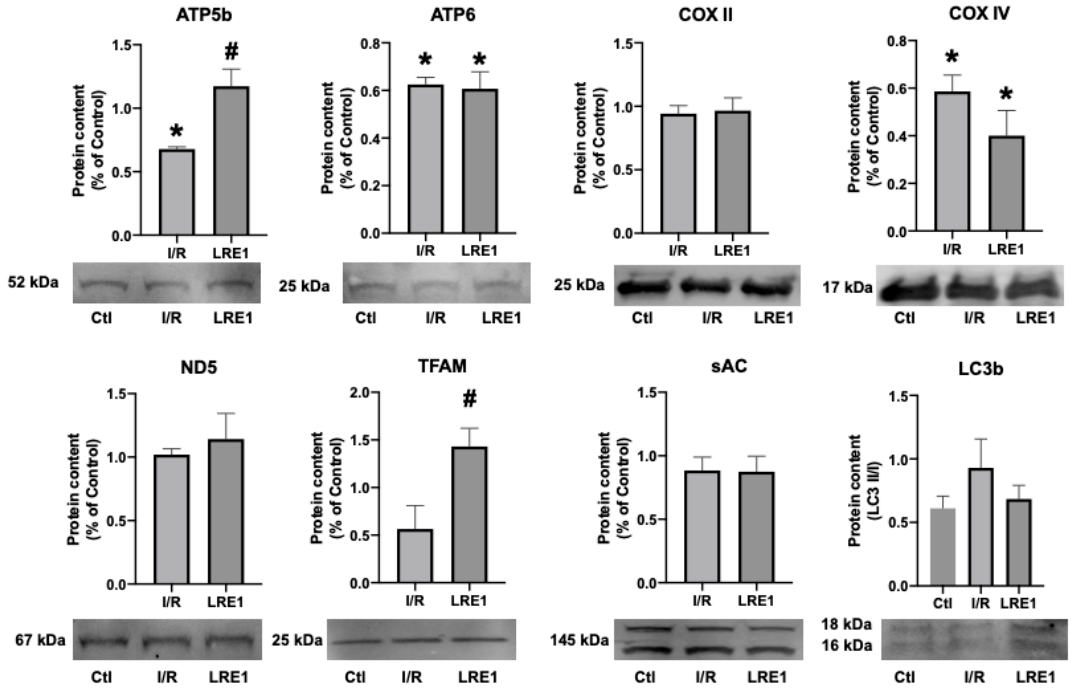
Figure 6. Hepatic mitochondrial protein content quantification by Western blot. Data are means ± SEM of 4 independent experiments. ATP5b, ATP synthase F1 subunit beta, mitochondrial; ATP6, ATP synthase F O subunit 6, mitochondrial; COX II, cytochrome c oxidase subunit II; COX IV, cytochrome c oxidase, subunit IV; ND5, NADH-ubiquinone oxidoreductase chain 5; TFAM, mitochondrial transcription factor A; sAC, soluble adenylyl cyclase; LC3b, microtubule-associated proteins 1A/1B light chain 3B. * indicates a statistically significant difference vs. Ctl; # indicates a statistically significant difference vs. I/R.